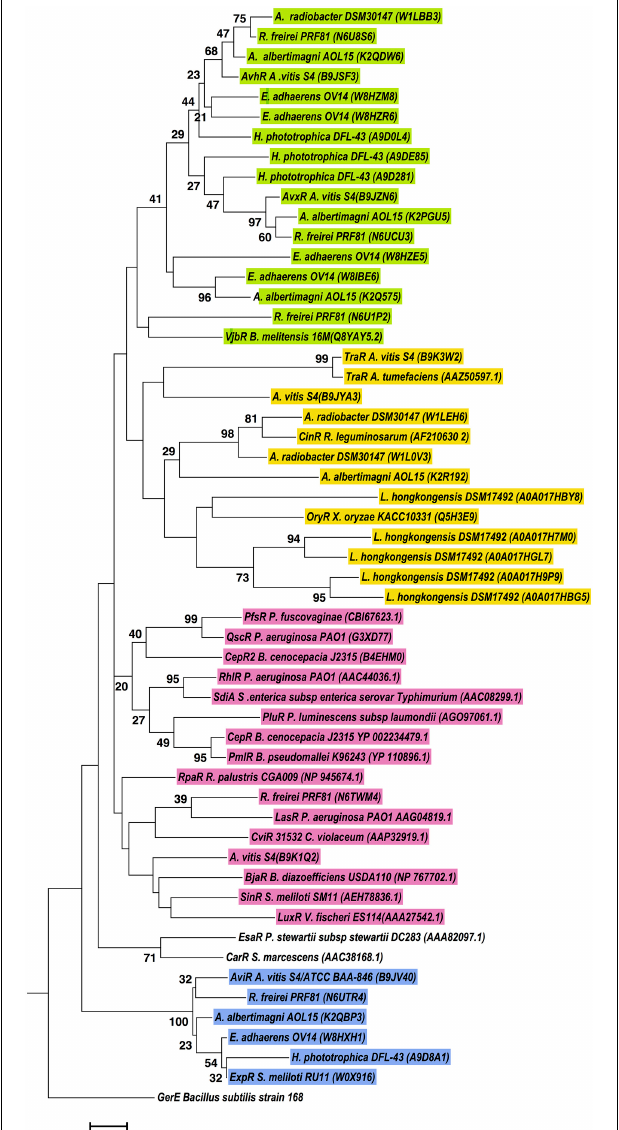
FIGURE 5 | Phylogenetic analyses of multiple LuxR solos carried by selected Alphaproteobacterial species. The tree was inferred by using the Maximum Likelihood method. Tree is drawn to scale, with branch lengths measured in the number of substitutions per site. The analysis involved 55 amino acid sequences, from representative species of this class carrying multiple LuxR solos. All positions containing gaps and missing data were eliminated. There were a total of 71 positions in the final dataset. Colors indicate major